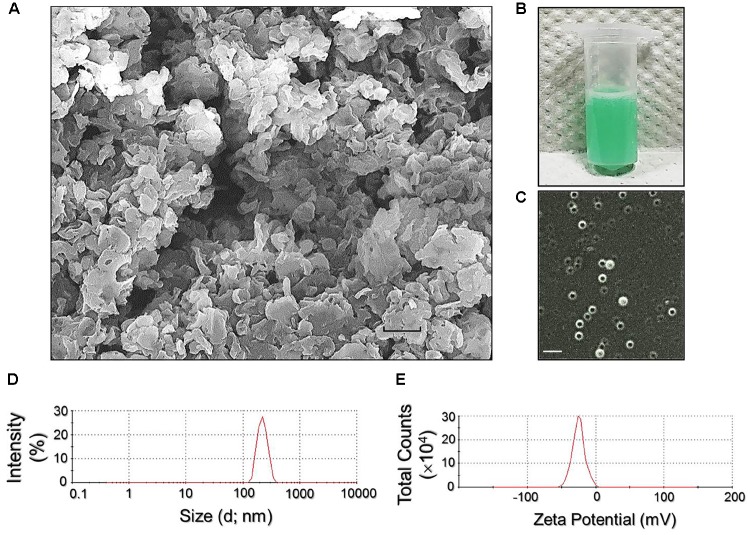
Assessment of physicochemical properties of the RIPNDs. (A) SEM image of the RIPNDs at 2000X magnification. Scale bar = 500 nm. (B) The appearance of the real RIPND sample. (C) Photomicrographic image of the RIPNDs at magnification of ×400. Scale bar = 3 μm. (D) Size distribution profile of the RIPNDs measured by DLS. (E) Surface charge (ζ-potential) distribution profile of the RIPNDs detected by DLS.